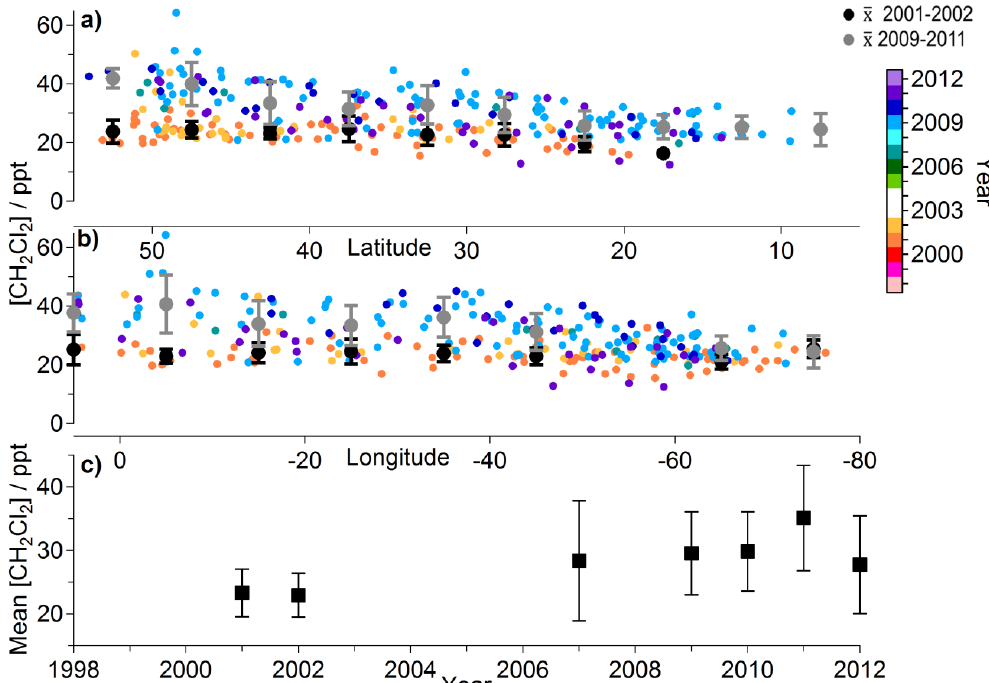
Figure 6. (a) Latitudinal and (b) longitudinal distributions of CH 2 Cl 2 along flight routes across the North and Central Atlantic to Central America where colour = year (see inset colour bar, colour scale is consistent with Figs. 2, 4 and 6). Average, ¯ x , values for 5 ◦ latitude and 10 ◦ longitude bins are shown for 2001–2002 and 2009–2011 (see Sect. 3.4), error bars are the 1 σ variation within these bands. (c) Annual tropospheric values (see Fig. 2) with 1 σ error bars.